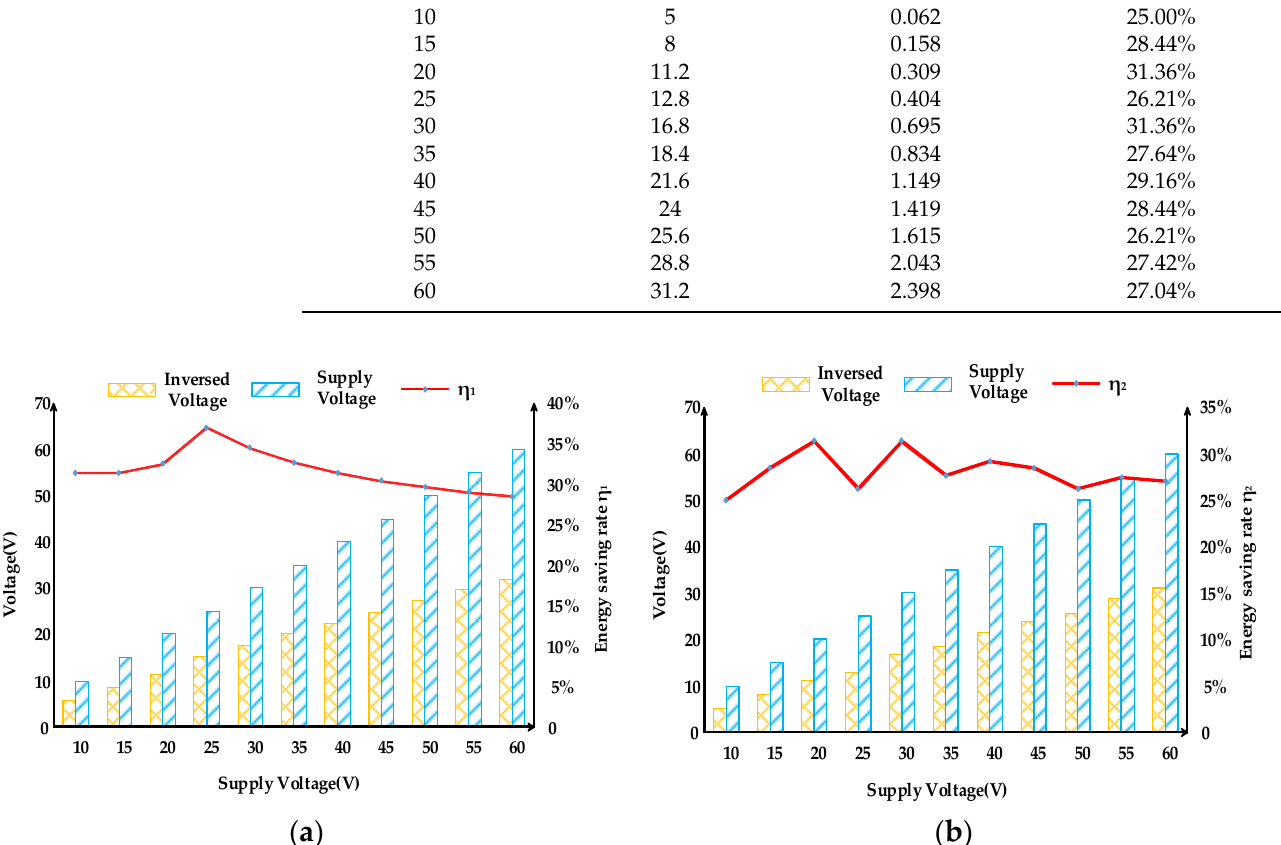
Figure 15. Power consumption at different frequencies. 5.2.3. Vibration Displacement and Cooling Effect of the PE Fan In our experiment, the piezoelectric constant is stationary, so the displacement of the PE fan depends on the magnitude of the applied electric field. Both circuits generated a quasi-square wave voltage of 30 V. Since PE fans have a better cooling effect and consume less power at the first resonant mode than at the higher resonant mode [37], it operates at the first resonant frequency of 24.2 Hz. As shown in Figure 16, the vibration displacement of the PE fan driven by the conventional circuit, DID circuit, and SID circuit is almost the same, about 9 mm. Therefore, the driving performance of the proposed inductor-based circuit is comparable to that of the conventional circuit while saving energy.